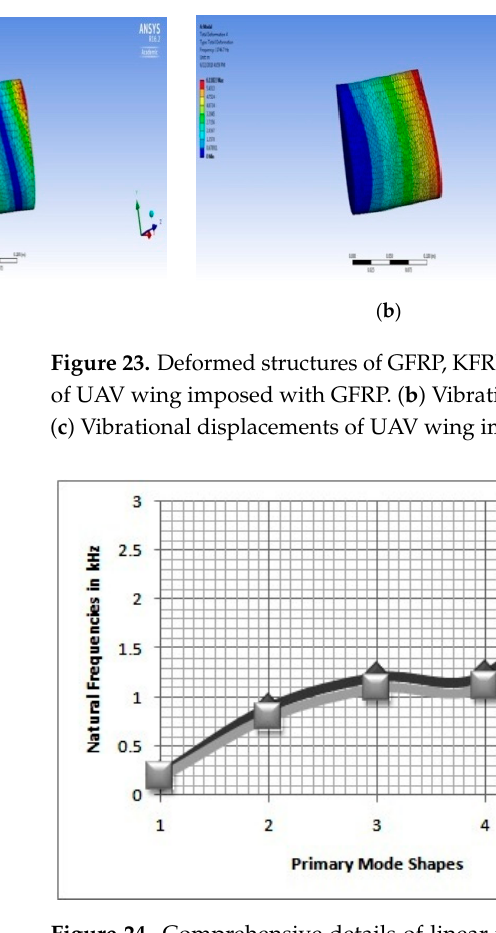
Figure 22. Comprehensive details of linear mode shapes versus natural frequencies for different composites—Wind Turbine Blade.